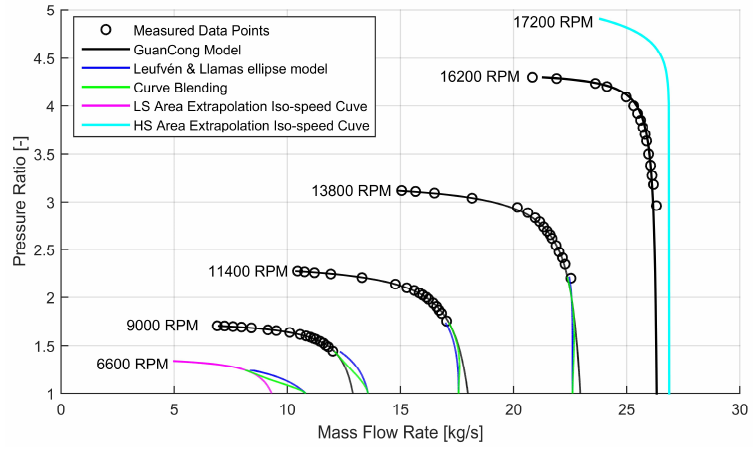
Figure 5. Prediction and extrapolation result of the zonal compressor mass flow rate model.